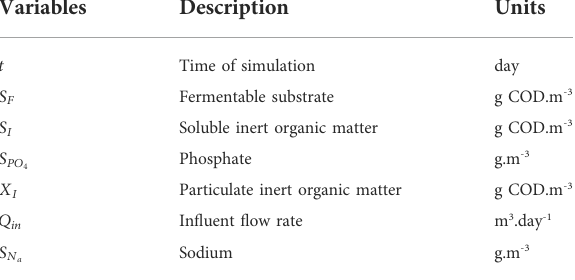
TABLE 1 Exogenous input variables related to OCI and